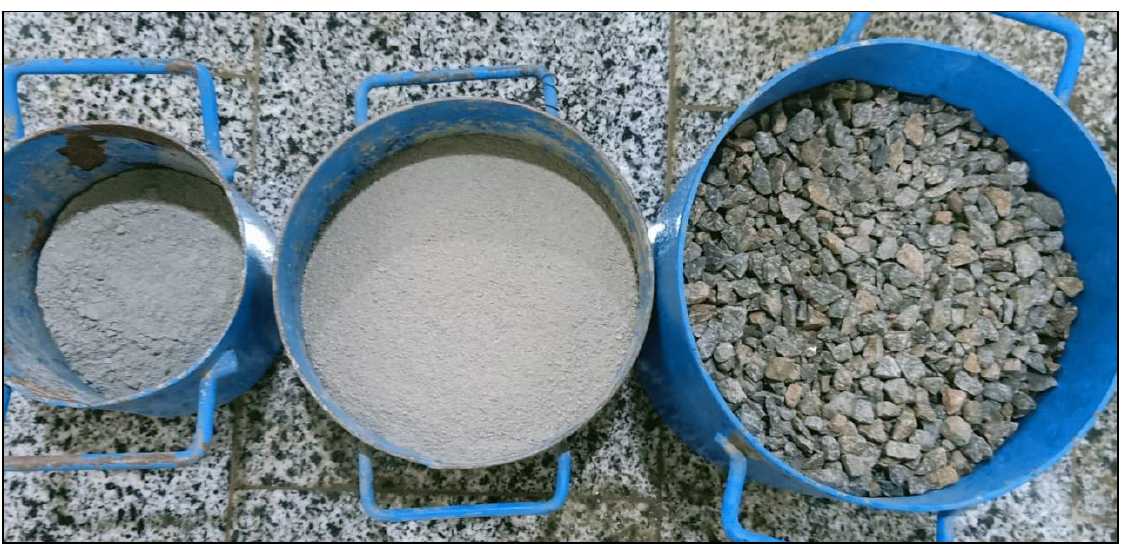
Figure 2. Volcanic rocks as coarse aggregate, fine aggregate, and volcanic ash.